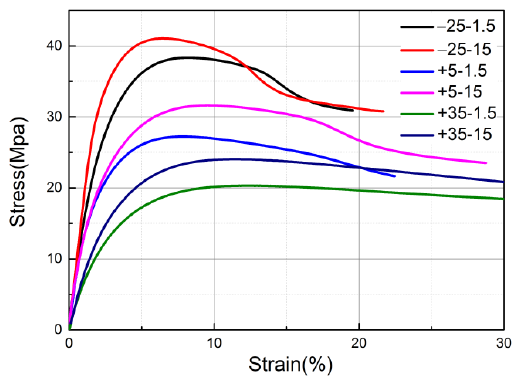
Figure 3. Stress–strain curves at different temperatures and tensile